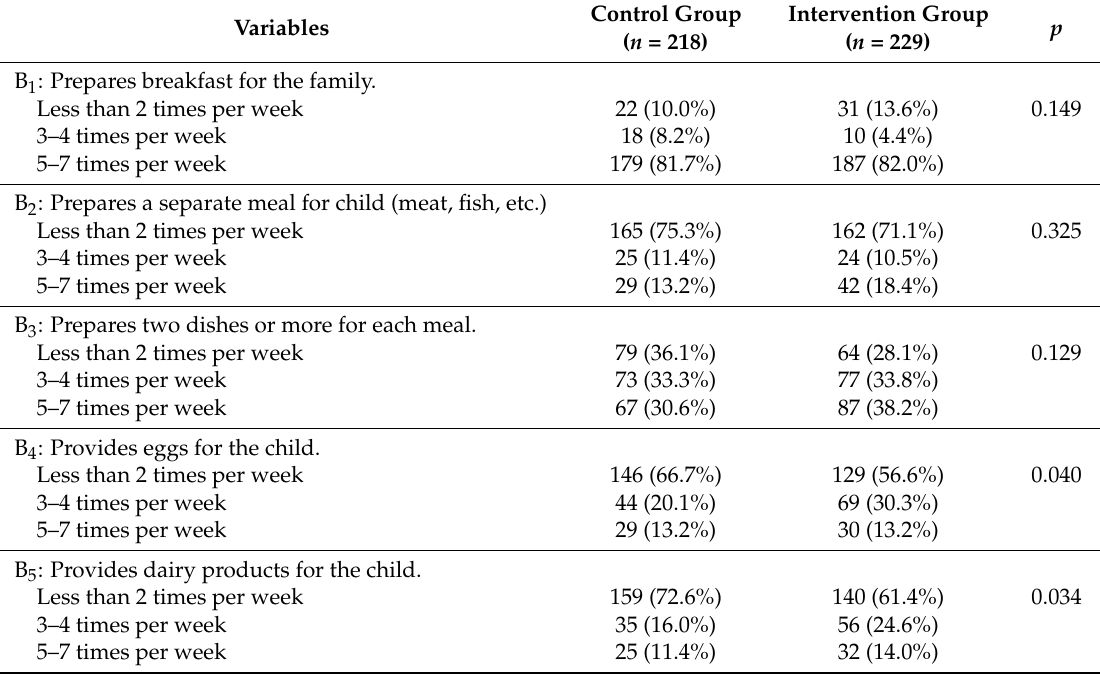
Table 3. Comparison of food practice behaviors between the intervention group and the control group of CLBC at the end of the intervention.